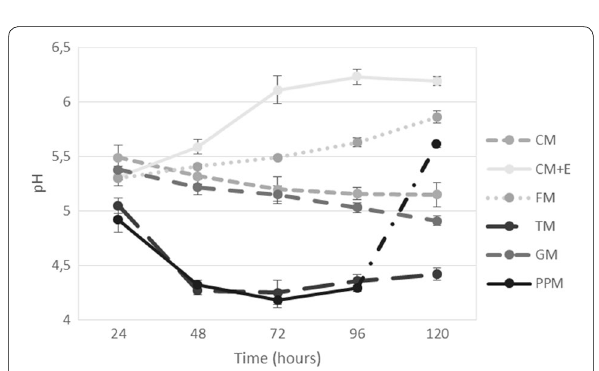
Fig. 3 pH variation with time for each